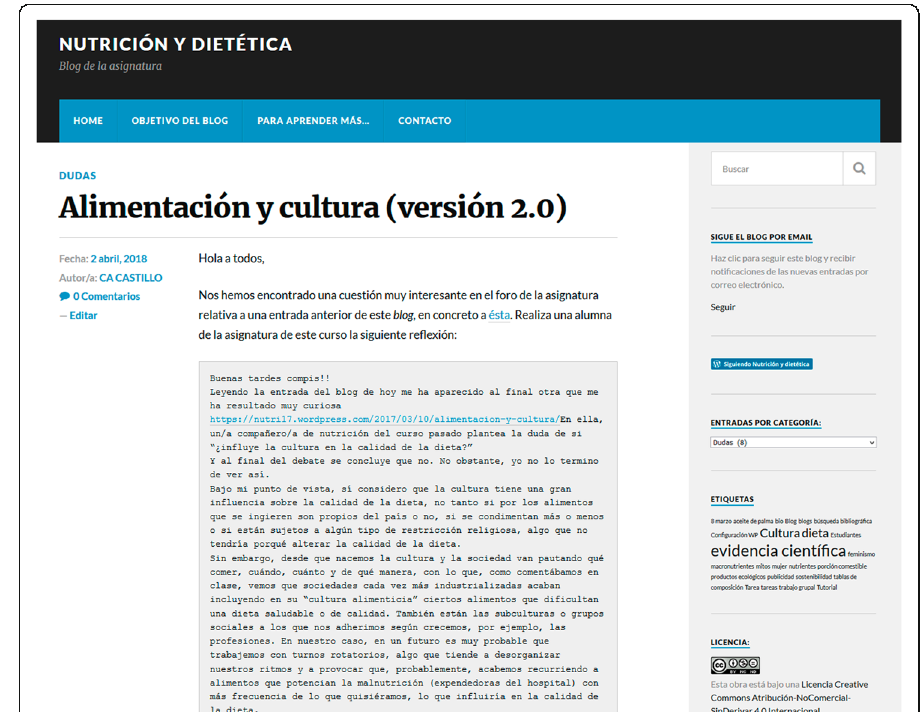
Fig. 4 Typical content of a post answering a student ’ s question. Generally, the selected student question was shown in a box and used as a guide to direct the content of the post. In this example, the influence of culture in human diet is discussed. Available at: